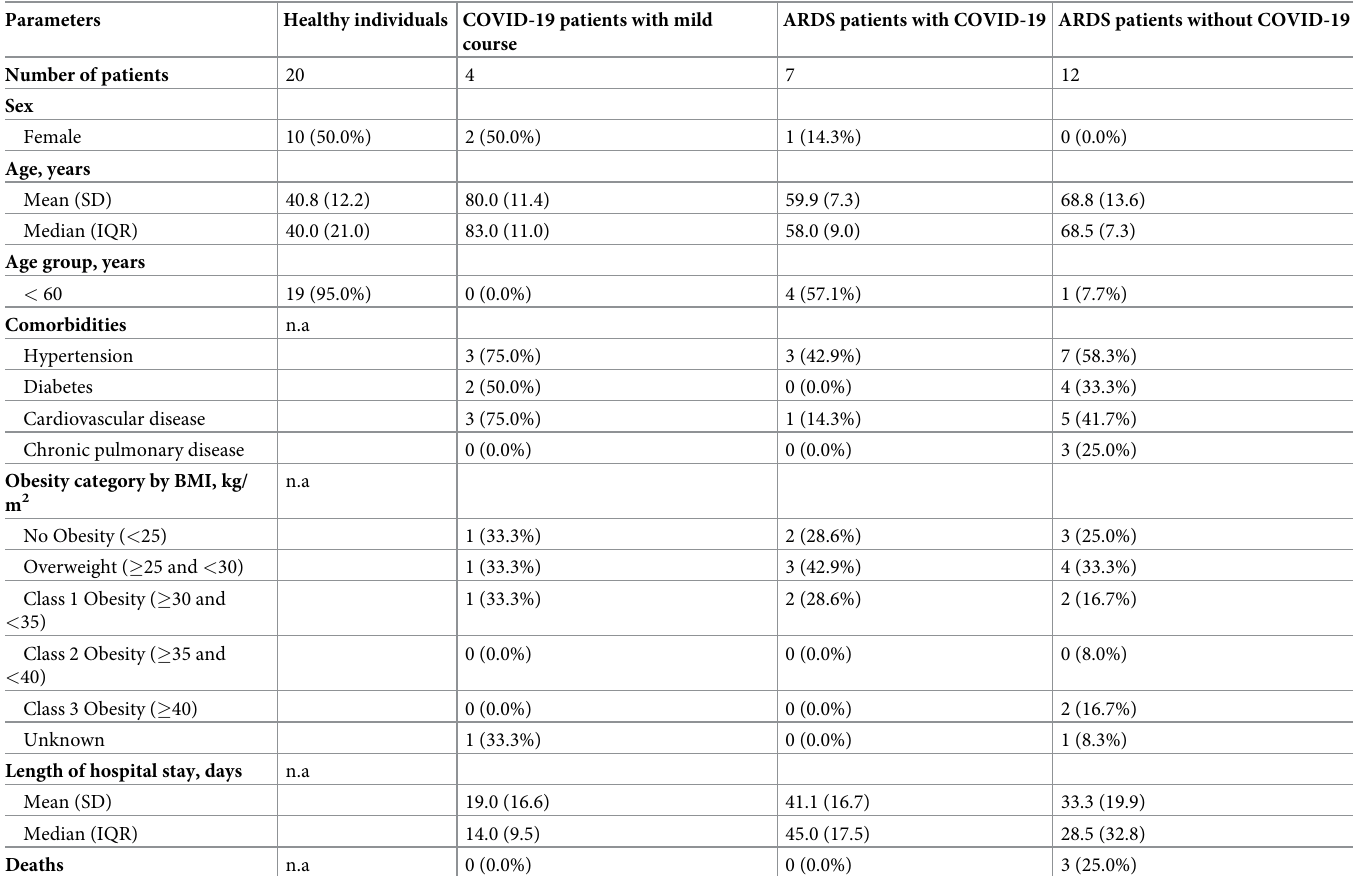
Table 1. Patient